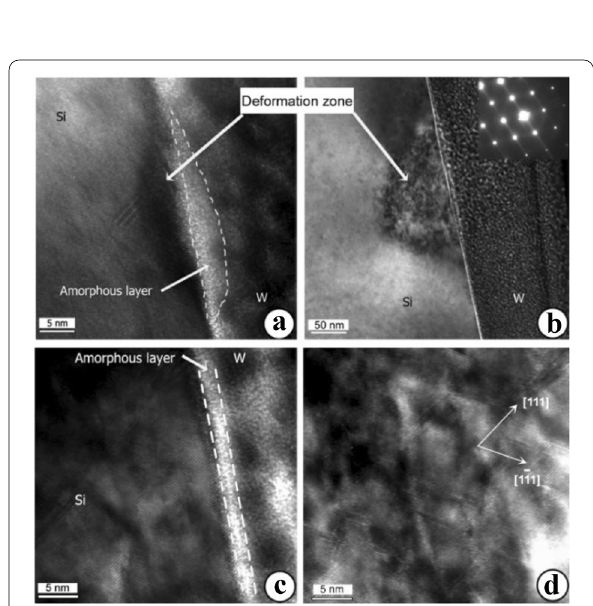
Figure 9 XTEM microstructure of the silicon hillocks created at various sliding speeds in vacuum [26]: ( a ) XTEM microstructures of the hillock created at v 10 μm/s, and ( b ) v 1000 μm/s. The inset = = SAD pattern in ( b ) was taken from the area under the hillock, ( c ) and ( d ) high resolution TEM microstructures of amorphous layer and deformation zone in ( b